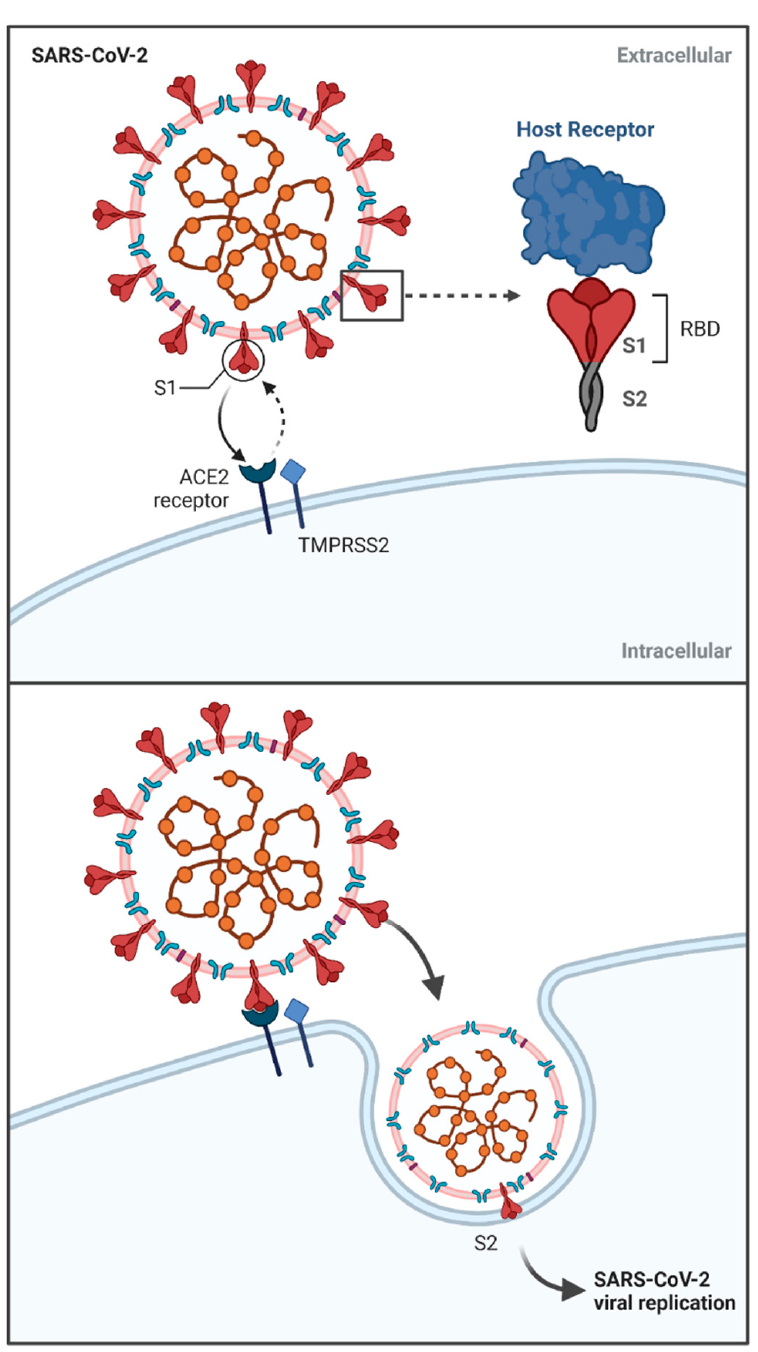
Figure 2. Mechanism of SARS-CoV-2 viral entry. Viral S glycoprotein contains two subunits: S1 and S2, with S1 constituting receptor binding domain (RBD). S1 subunit associates with host cell’s receptor ACE2 with the participation of TMPRSS2, which leads to conformational changes in S1 subunit and endosomal reaction. Subsequently, S2 subunit activates host cell fusion with viral particles, leading to viral replication. Abbreviations: ACE2—angiotensin-converting enzyme 2; RBD—recep- tor binding domain; TMPRSS2—transmembrane protease serine 2. Created with BioRender.com (accessed on 8 May 2021).